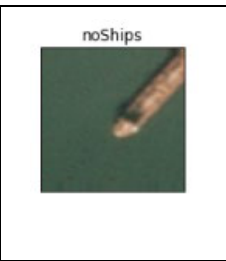
Figure 9. Sample image of mislabelled data